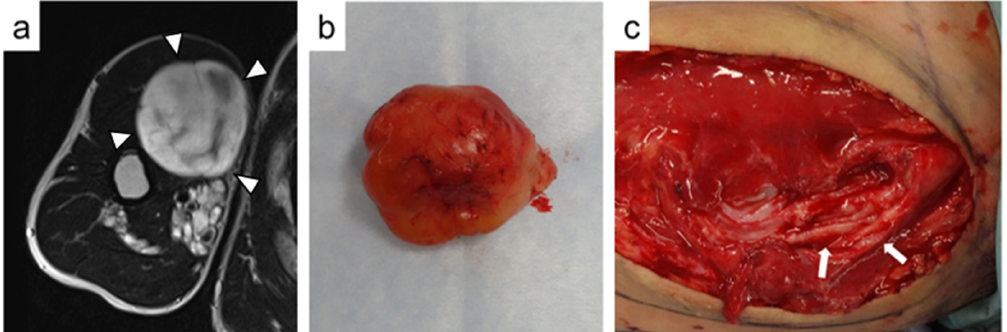
Figure 2. A 26 ‐ year ‐ old male with nodular plexiform neurofibroma in the right upper arm (Case 8). ( a ) On axial T2 ‐ weighted magnetic resonance image, the tumor shows high signal intensity with some hypointense areas (arrowheads). ( b ) The tumor is successfully enucleated (Tumor 11). ( c ) An intraoperative photograph showed that the musculocutaneous nerve is preserved with a capsule after enucleation of the tumor (arrows).